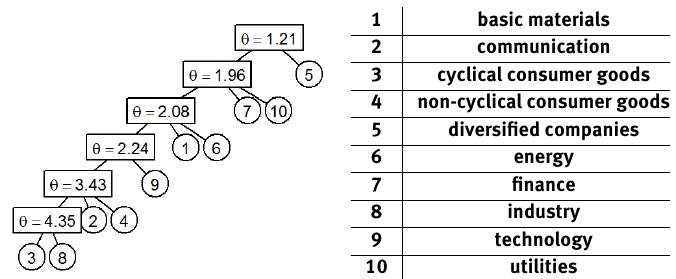
Fig. 5. Hierarchical Archimedean copula estimated from default data.